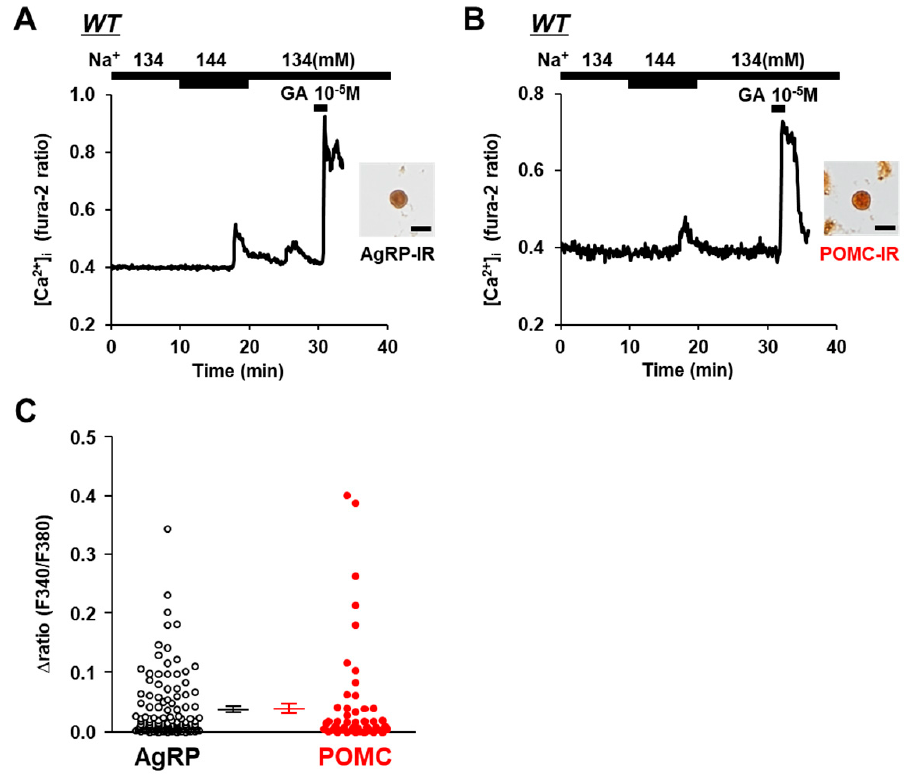
Figure 1. Increased extracellular [Na + ] increased [Ca 2+ ] i in single AgRP and POMC neurons isolated from ARC of wild-type mice.( A , B ) Left panel: Typical examples of [Ca 2+ ] i responses to [Na + ] increase and 10 − 5 M glutamate (GA) in single ARC neurons. Right panel: The single ARC neurons were subsequently shown to be IR to AgRP ( A ) and POMC ( B ). Scale bar is 20 µ m. ( C ) Average amplitude of [Ca 2+ ] i responses to increased extracellular [Na + ] ( ∆ ratio) in AgRP and POMC neurons. Data are presented as mean ± SEM. The involvement of the osmotic sensor TRPV1 in extracellular [Na + ] sensing in POMC and/or AgRP neurons was investigated using TRPV1 KO mice. Elevating the extracellular [Na + ] from 134 mM to 144 mM increased the [Ca 2+ ] i in POMC the neurons of the wild- type mice (Figure 2A), and this response was completely abolished in the POMC neurons isolated from the TRPV1 KO mice (Figure 2B). None of the twelve POMC neurons in the TRPV1 KO mice responded to the 10 mM increase in extracellular [Na + ] (Figure 2C). Conversely, the elevation of extracellular [Na + ] from 134 mM to 144 mM increased [Ca 2+ ] i in 5 of 78 (6.4%) AgRP neurons in the TRPV1 KO mice and 6 of 118 (5.1%) AgRP neurons in the wild-type mice (Figure 3A,B). No significant differences were observed in the amplitude of the [Ca 2+ ] i increase in the AgRP neurons between the C57BL/6 and TRPV1 KO mice (Figure 3C). These results indicated increased TRPV1-dependent sensing of [Na + ] by POMC neurons but not AgRP